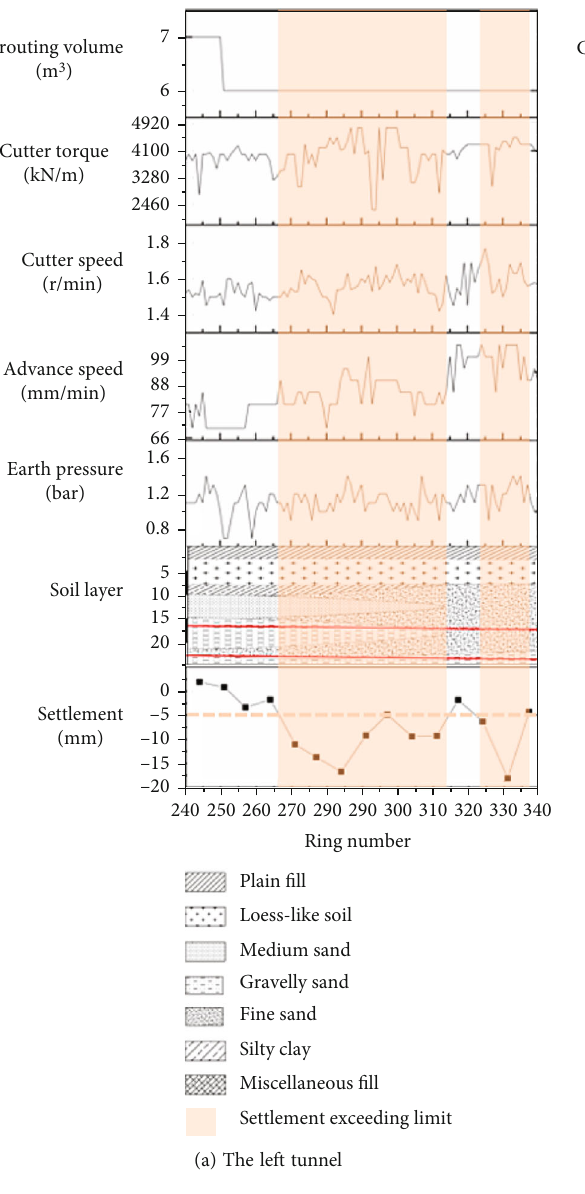
Figure 4: The driving parameters and the surface settlement in the test